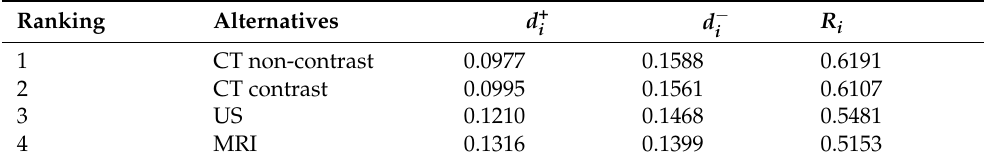
Table 6. Ranking of the acute appendicitis diagnosis for high AIR score by F-TOPSIS approach.